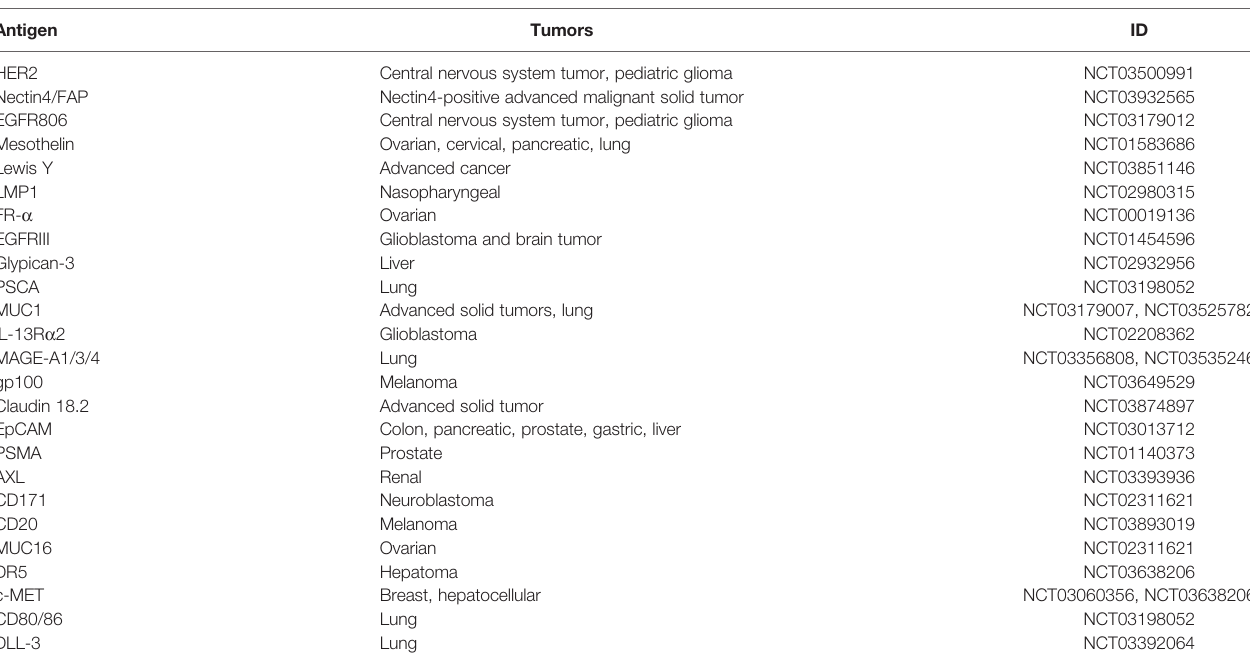
TABLE 2 | Targets in clinical trials in solid tumor CAR-T therapy. Antigen Tumors ID HER2 Central nervous system tumor, pediatric